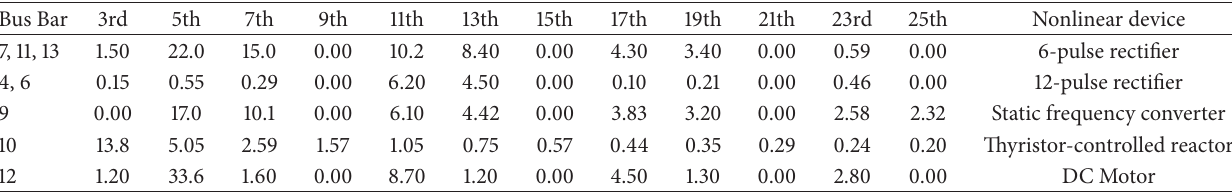
Table 1: Harmonic current components in percentage by field